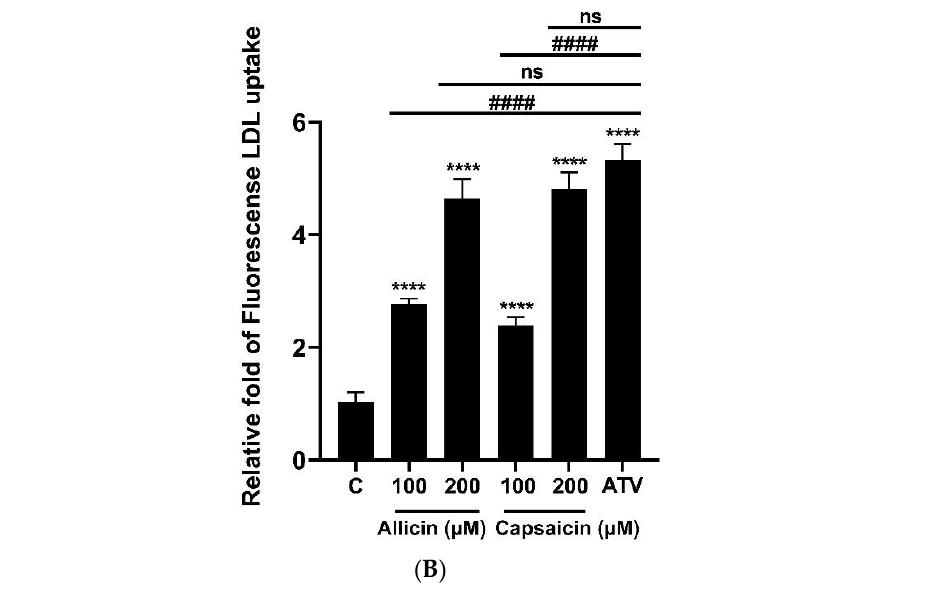
Figure 5. Effects of allicin (100 µM and 200 µM) and capsaicin (100 µM and 200 µM) on LDL uptake in HepG2 cells ( A ). Confocal laser images represent the cell-associated BODIPY-LDL (green), Draq5 (red) and the overlay. A representative blot is shown ( B ). HepG2 cells were treated with allicin (100 µM and 200 µM), capsaicin (100 and 200 µM), or atorvastatin (10 µM) for 24 h, and LDL uptake was determined by confocal laser scanning microscopy. The relative fluorescence intensity was analyzed by ImageJ software. The data represent the mean ± SEM of three independent experiments ( N = 3). **** p < 0.001 represent significant differences compared to the vehicle-treated cells or the control group (C) . #### p < 0.001 represents significant differences compared to atorvastatin (ATV)-treated cells. ns: not significant.